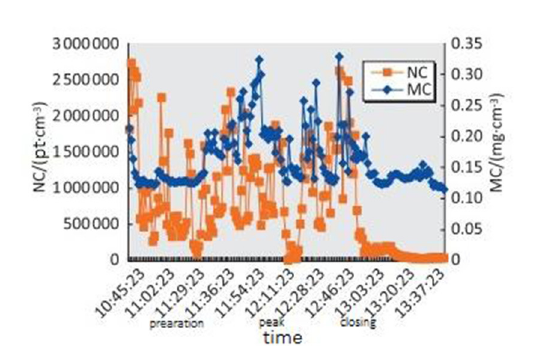
of particles, or the particle diameter corresponding to the maximum NC of the particles at lunch peak, exposed to different cooking posts was analyzed using a one-way ANOVA with repeated data. The Pearson correlation method was used to analyze the correlations between NC, MC, and SAC. The significance level was set at α =